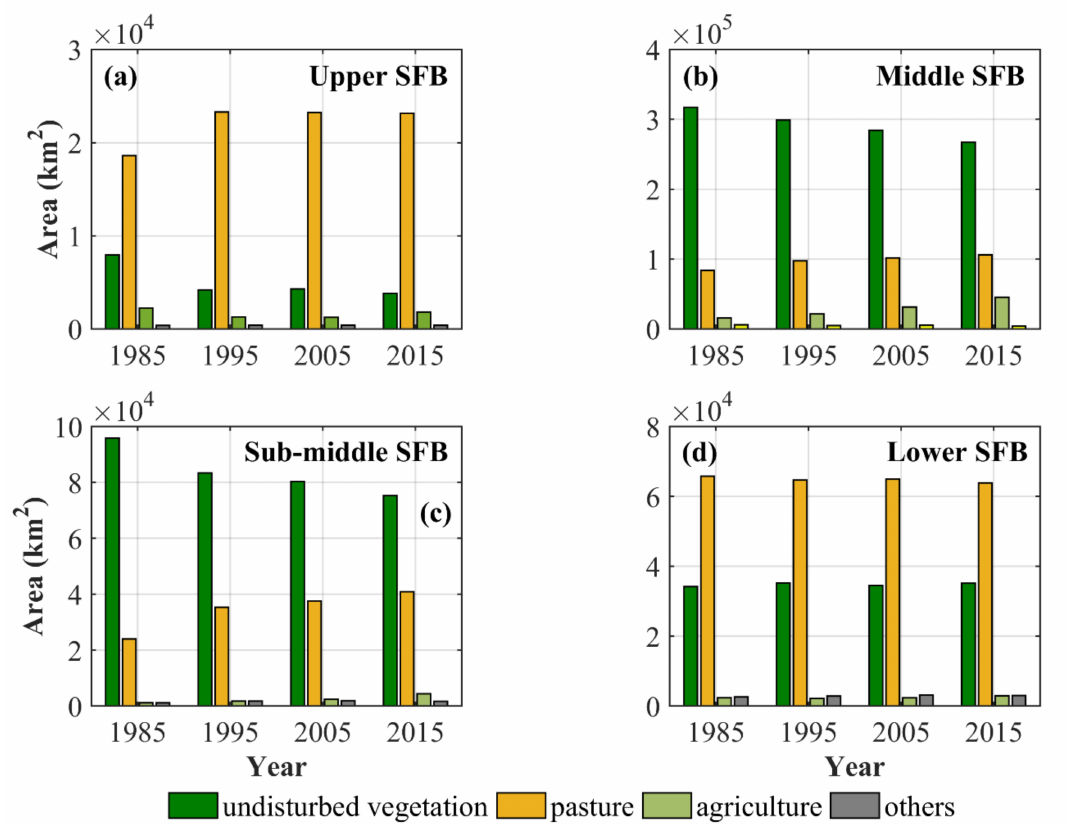
Figure 6. Land use and cover area according to the hydrographical regions of the Sao Francisco River Basin (SFB) during 1985–2015: ( a ) Upper SFB, ( b ) Middle SFB, ( c ) Sub − middle SFB and ( d ) Lower SFB. Land use classes were acquired from MapBiomas 3.0